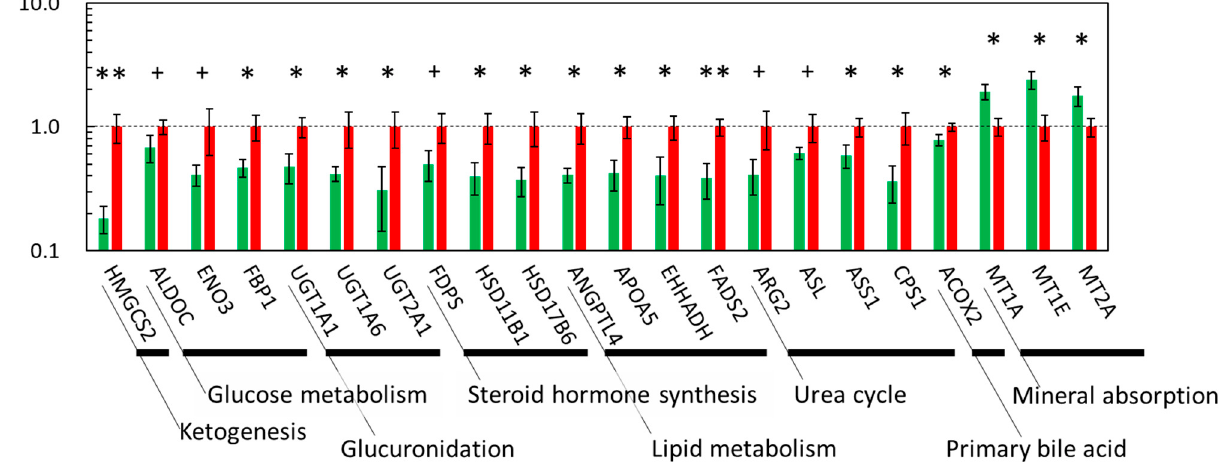
Figure 4. qPCR results of down- and upregulated fetal liver genes associated with essential liver metabolisms. The ratios of the normalized gene expression of the LN (green) to HN (red) fetuses are shown as columns. RPLP0 was used as the internal control. Error bars indicate SEM. **, *, and + indicate differences between the LN and HN fetuses at p ≤ 0.01, ≤ 0.05, and ≤ 0.10, respectively.